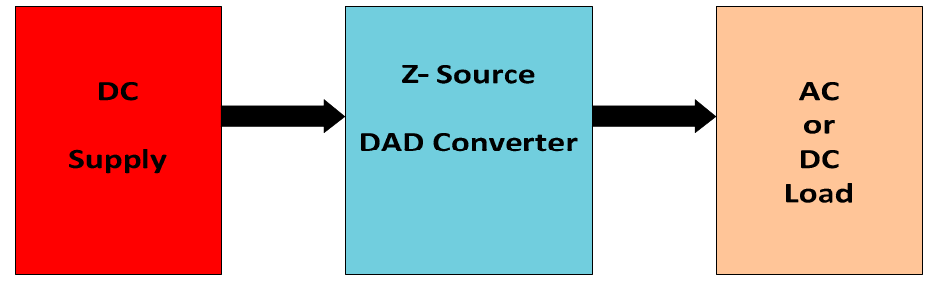
Figure 1. Z-Source direct current (DC)-to-alternating current (AC)/DC (DAD) converter system.